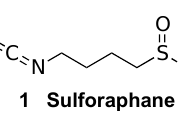
MeO CS S N 1 Sulforaphane Figure 4. Structure of sulforaphane, a multitarget compound that is able to inhibit TLR3-mediated NF-κB signaling and to induce NRF2 by covalently binding to KEAP1.